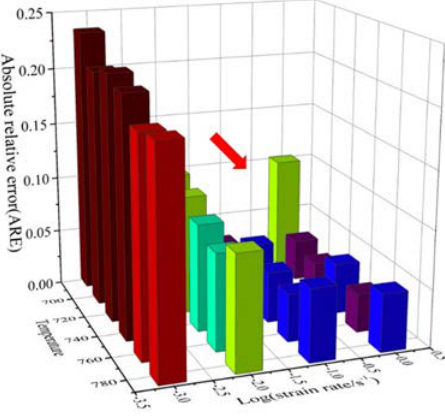
Metals 2017 , 7 , 114 10 of 12